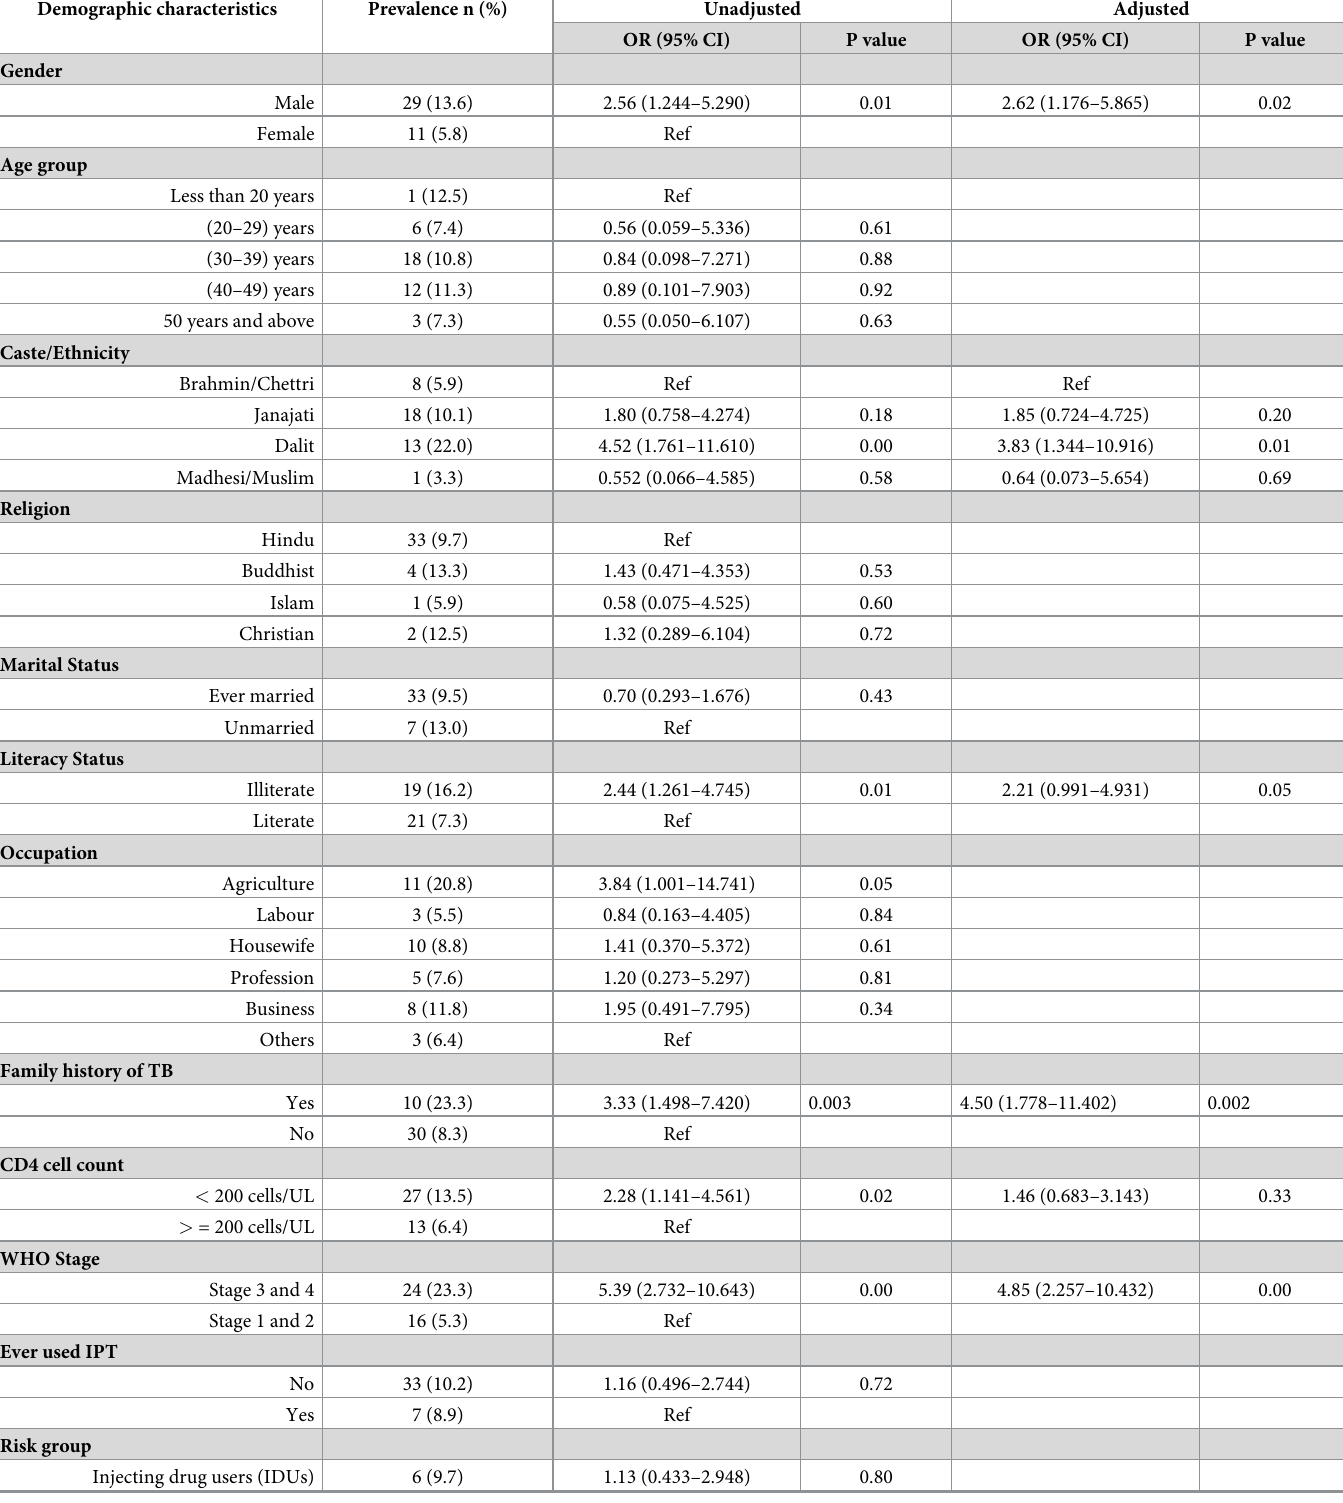
Table 2. Association between socio demographic and clinical characteristics with the development of TB in PLHIVs (N =